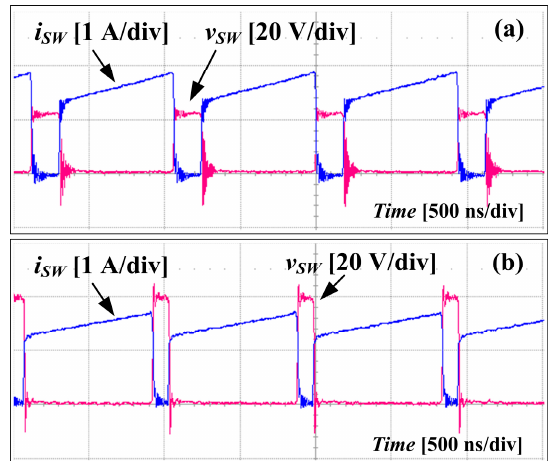
Figure 9. Voltage and current waveforms of switch measured at V IN = 5 V, V O = 40 V, I O = 150 mA, and f S = 1 MHz. ( a ) Proposed converter, ( b ) conventional boost converter.